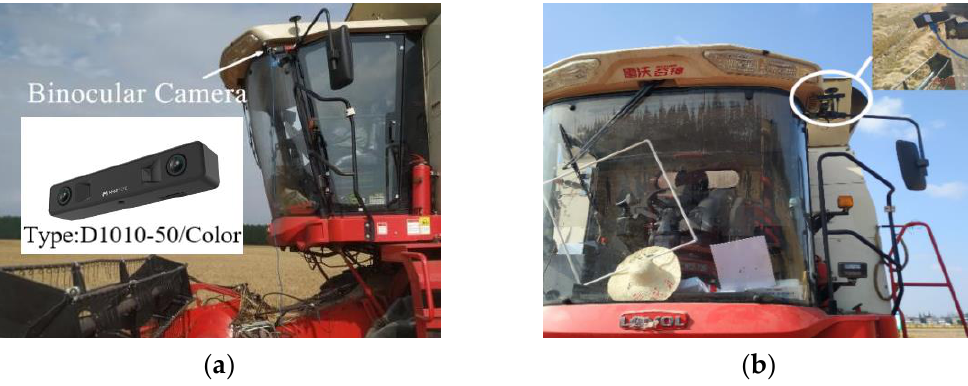
Figure 6. Binocular camera installation diagram. ( a ) Side view; ( b ) Front view.